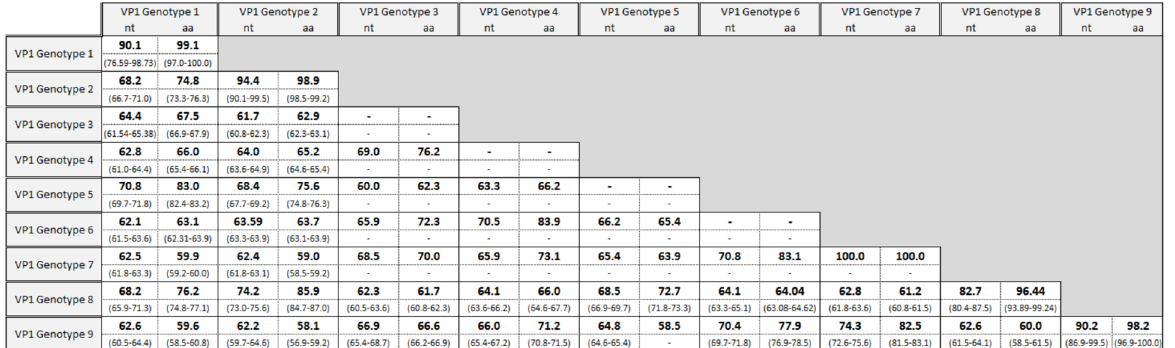
Figure 2. VP1 genotypes identified from 393 nt fragments in wild rodents from this study and available in public databases and mean values of inter- and intra-genotype identity (and range) of nt and amino acid sequences 1 . 1 Genotype 1: 87-012 (GenBank acc. no.: AF327920.2) and 174F (AF327921.2); genotype 2: 145SL (AF327922.2), 340 (KR045607.1) and 342 (KR045608.1); genotype 3: M1146 (AF538689.1); genotype 4: 64-7855 (EU854568.1); genotype 5: FUZ1 (LC133331.1); genotype 6: RtMrut-PicoV/JL2014-2 (KY432929)): (see Table 1). For genotypes 3, 4, 5 and 6, intra-genotype values are lacking because genotypes were represented by a single sequence.